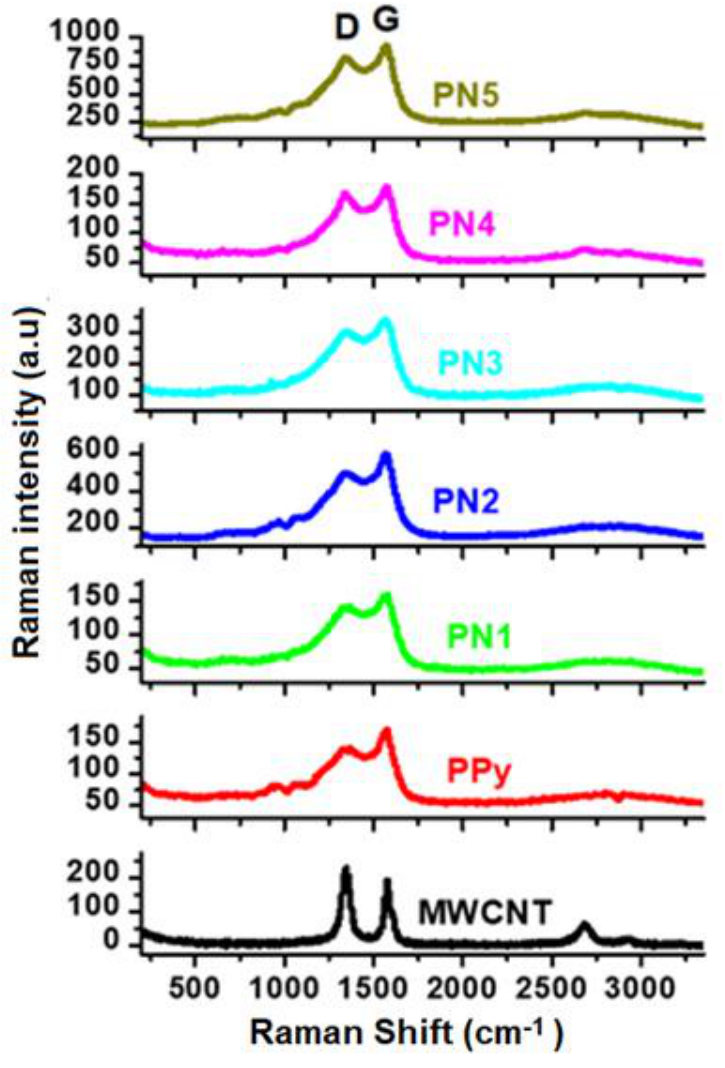
Figure 5. Raman spectra of the MWCNTs/PPy nanocomposites. Spectra of the pure MWCNTs and PPy are also shown.